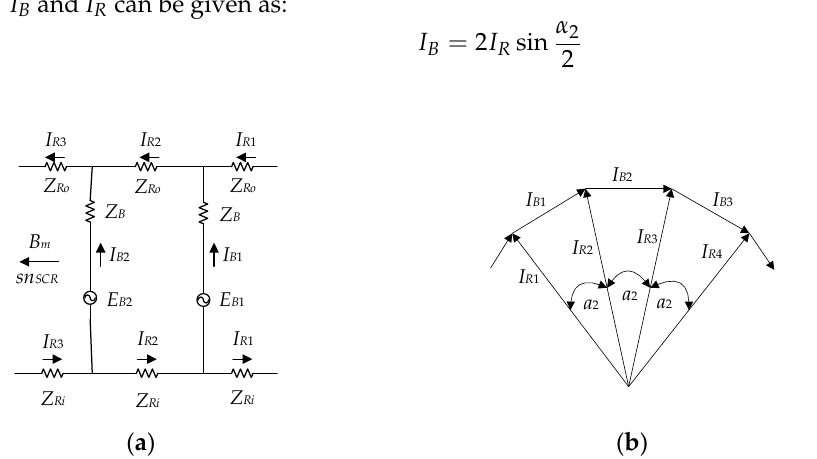
Figure 10. The equivalent circuit model of the PMECC with slotted CR: ( a ) equivalent circuit; ( b ) current vector diagram.